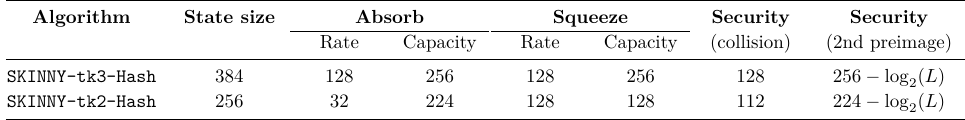
Table 4: Parameters for SKINNY-Hash . The number of blocks of the first preimage is denoted by L .